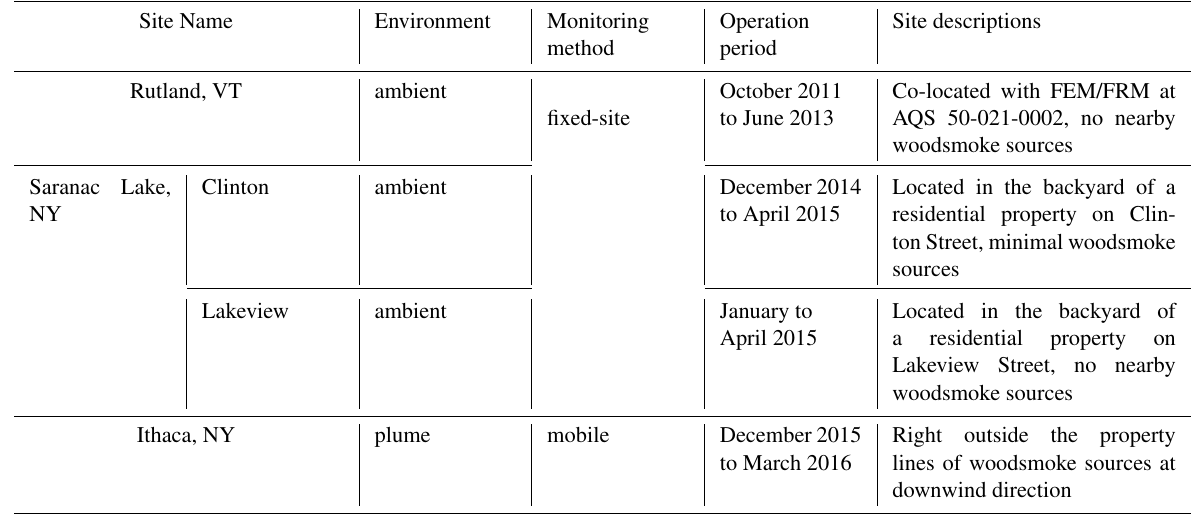
Table 1. Descriptions of field measurement sites